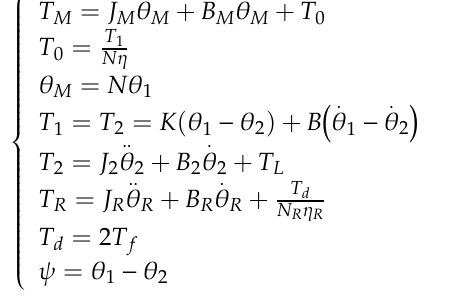
Table 4. The meaning of each parameter in the dynamical model of